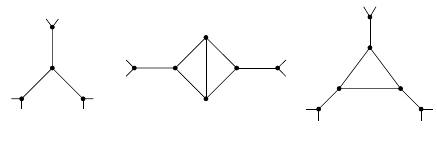
Figure 2: The reducible